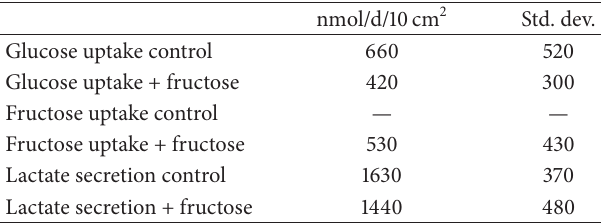
Table 1: Fructose is readily taken up by adipocytes. The amount (mean) refers to one confluent 10 cm 2 well (combined data of 14 days). Control: glucose only; fructose: glucose plus fructose in the media. nmol/d/10cm 2 Std.